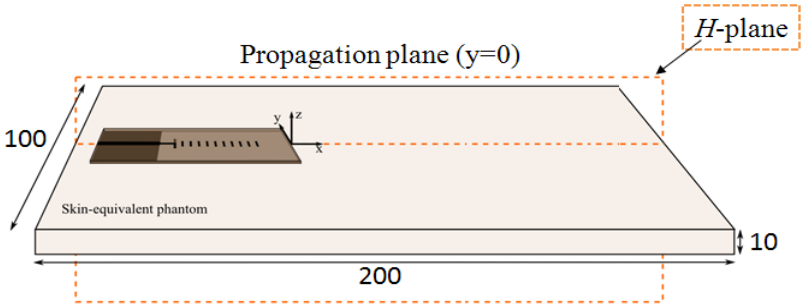
Figure 8. End-fire antenna on a rectangular skin-equivalent phantom (dimensions are in mm).